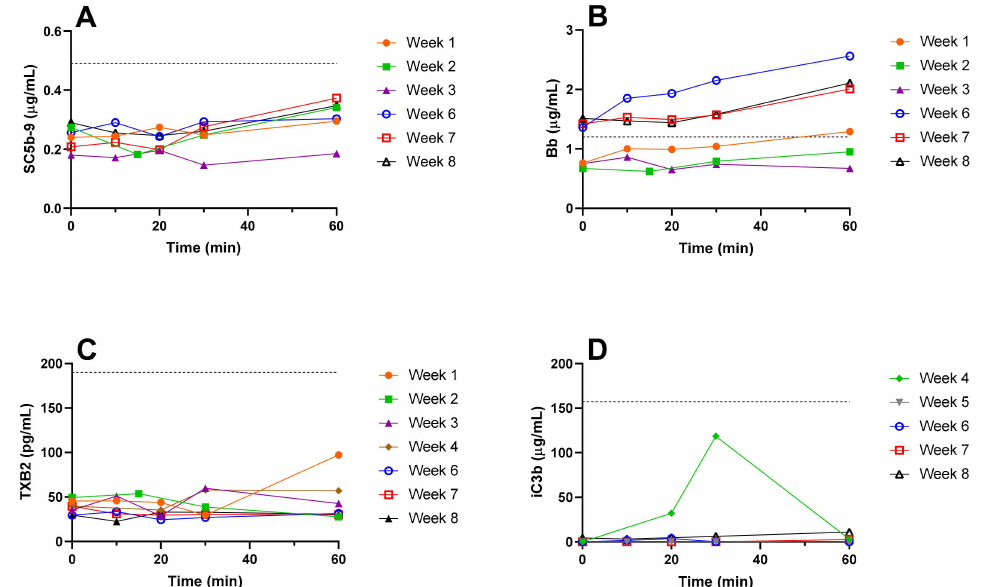
Figure 5. Markers of in vivo complement activation in plasma. Immediately before the beginning